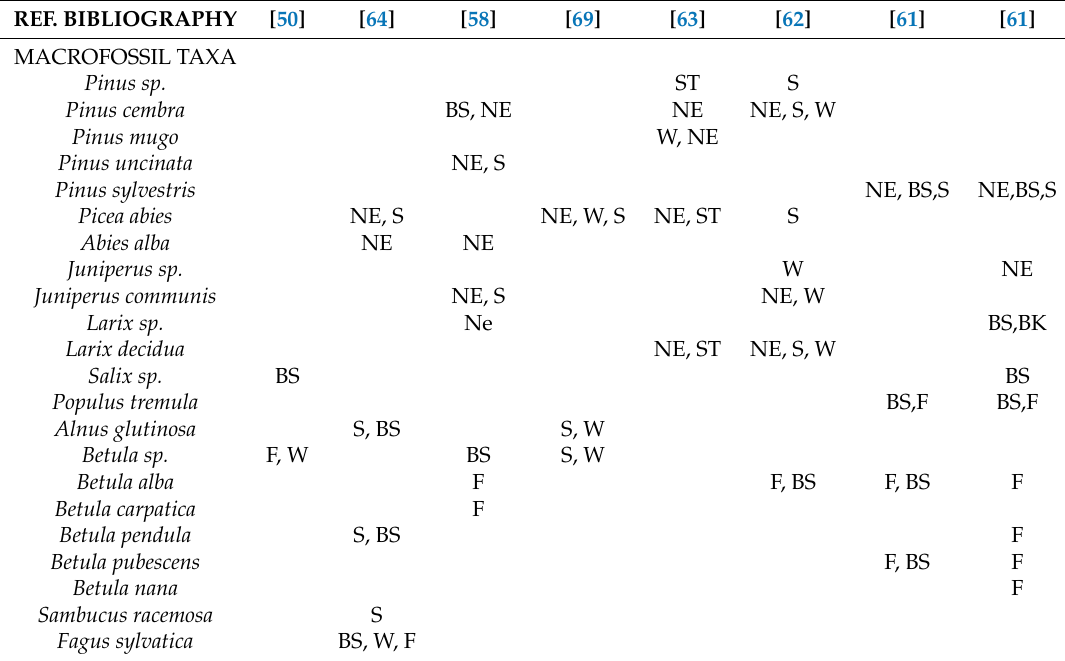
Table 3. Macrofossil arboreal taxa for central zone. Abbreviations: S—seeds, F—fruit, W—wood, BS—bud scales; NE—needles; BK—bark; ST—stomata. Ref.: The references correspond to